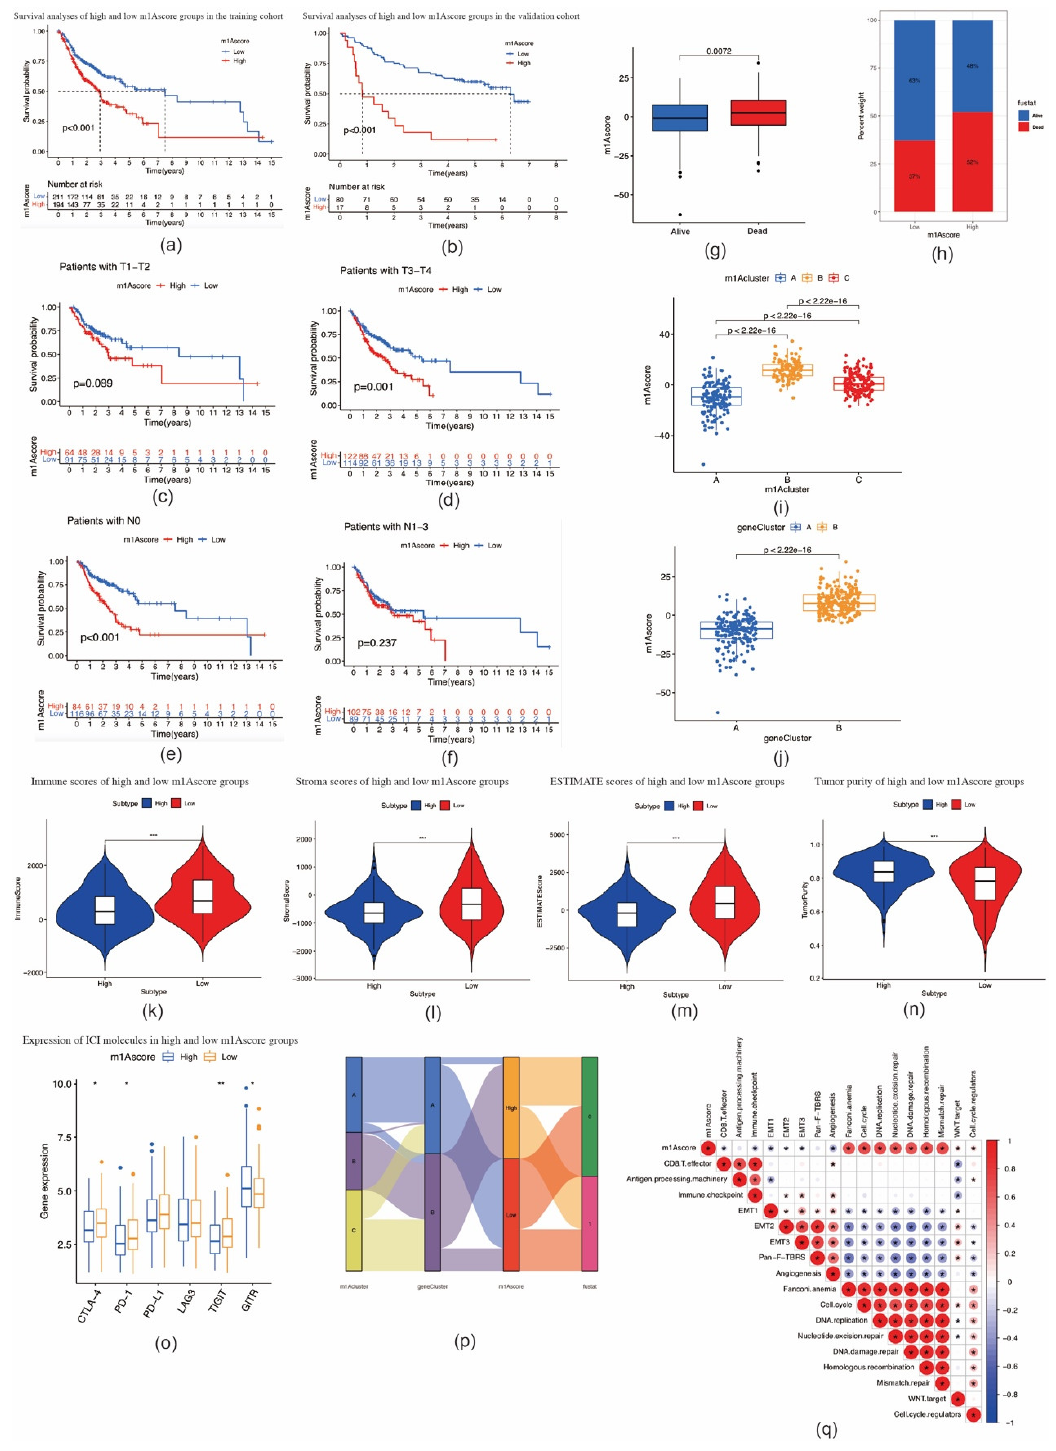
Figure 6. Construction of m1A score and exploration of the relevance of clinical features. ( a ) Survival analyses for patients with oral squamous cell carcinoma in the low and high m1A score groups ( p < 0.0001, log–rank test). ( b ) Survival analyses for low and high m1A score patients in validation cohort ( p < 0.0001, log–rank test). ( c , d ) Survival outcomes of low and high m1A score patients with oral squamous cell carcinoma at T1–T2 ( c ) and T3–T4 stages ( d ). ( e , f ) Survival outcomes of low and high m1A score patients with oral squamous cell carcinoma at N0 (e) and N1–N3 stages ( f ). ( g ) Differences in m1A scores between distinct survival status. ( h ) The proportion of survival status of patients in low or high m1A score groups. Alive/dead: 63%/37% and 48%/52% in the low and high m1A score groups, respectively. ( i ) Differences in m1A scores among three m1A modification patterns in patients with oral squamous cell carcinoma ( p < 0.001, Kruskal–Wallis